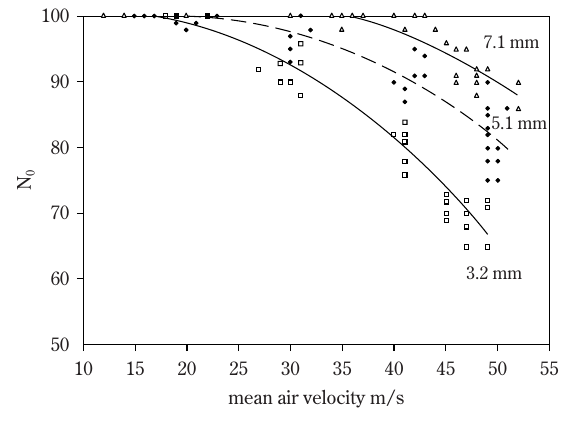
Fig. 10 Relationship between the number of unbroken fertiliser particles and mean air velocity for 3.2-mm, 5.15-mm